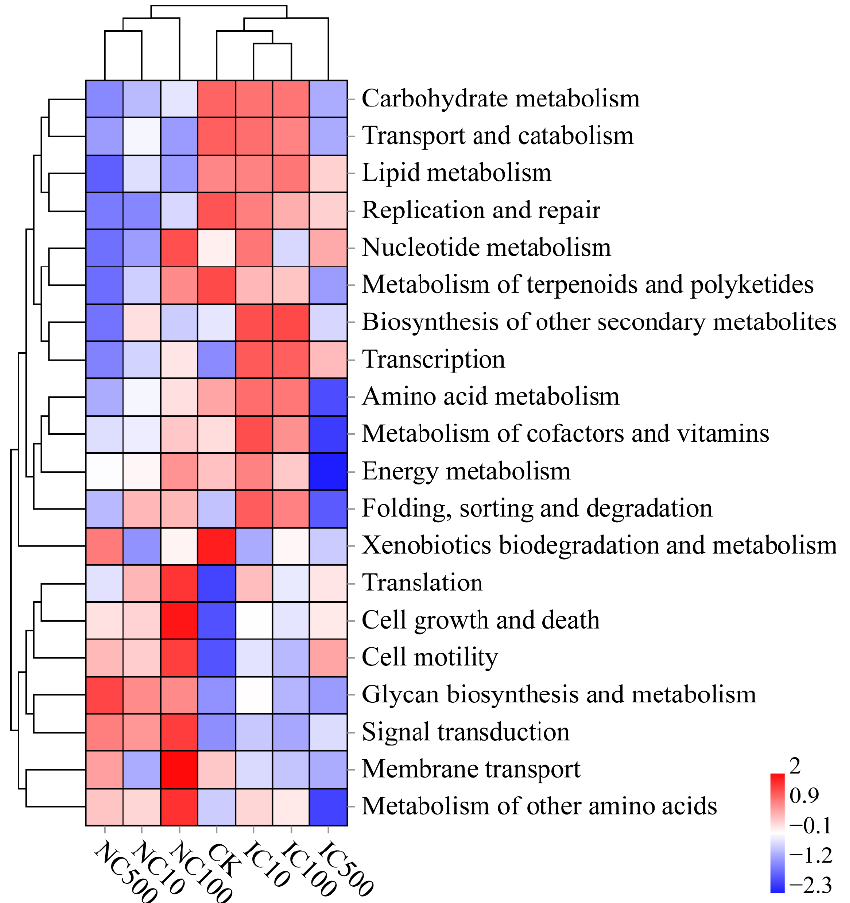
Figure 7. Hierarchical clustering heatmap of predicted bacterial potential functions by PICRUSt2. The heatmap is based on the normalized function abundance data. Warmer color (red) indicates a higher function abundance, while colder color indicates a lower function abundance.